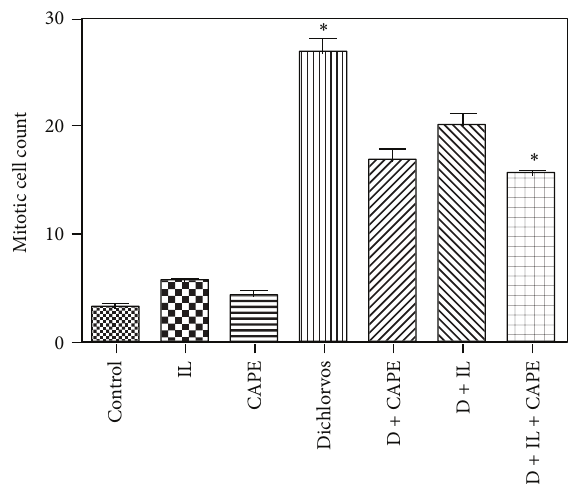
Figure 1: Histopathologic results for kidney tissues. Mitotic cell count. ANOVA test (intralipid (IL), Dichlorvos